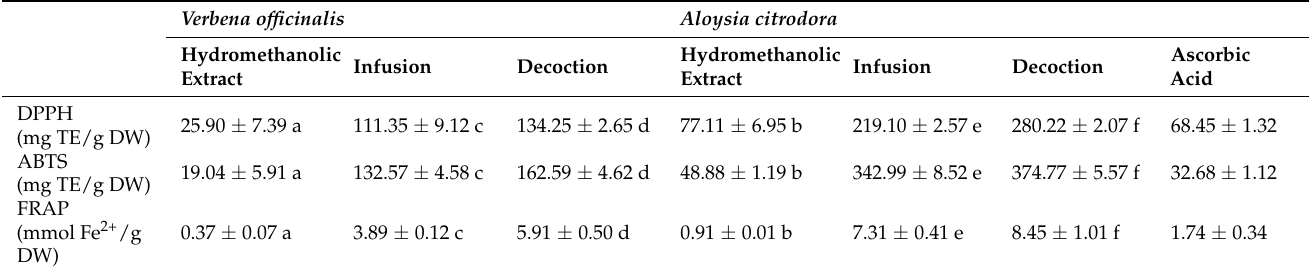
Table 5. Antioxidant activity of the hydromethanolic extract, infusion, and decoction of Verbena officinalis and Aloysia citrodora